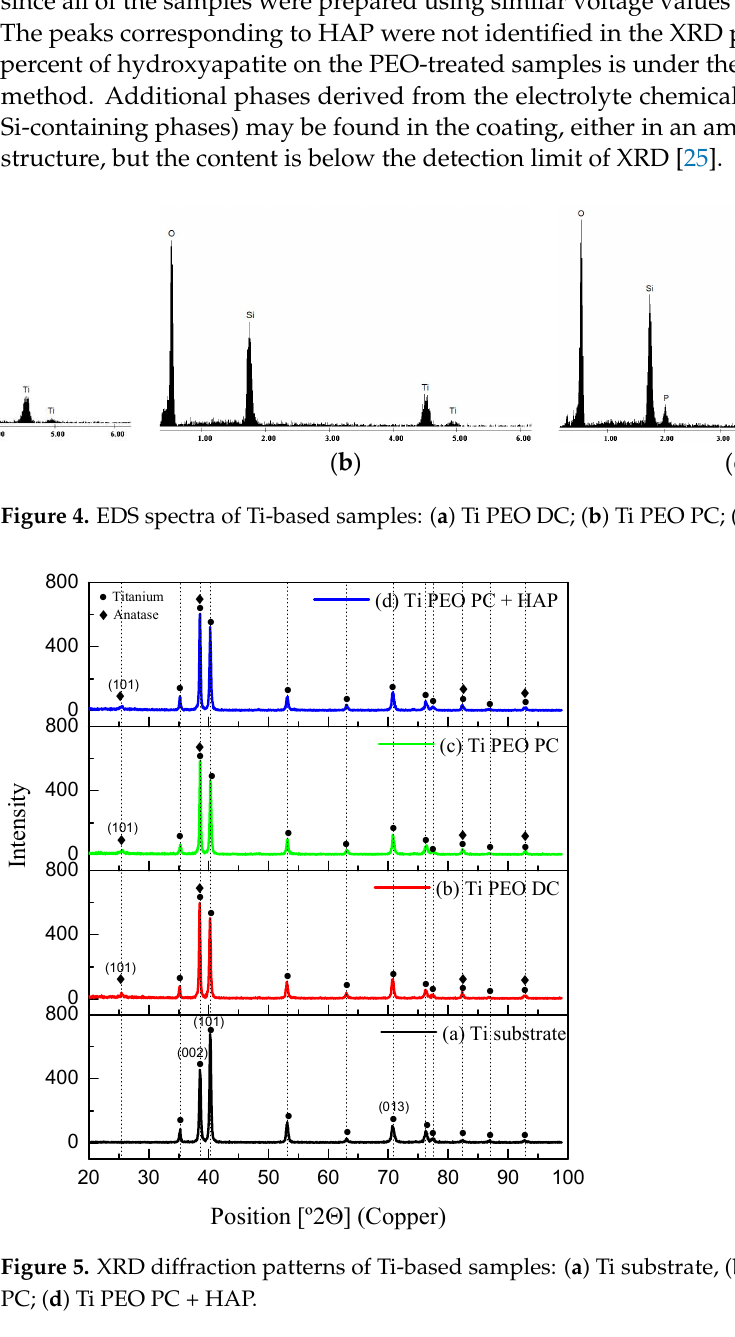
Figure 5. XRD diffraction patterns of Ti-based samples: ( a ) Ti substrate, ( b ) Ti PEO DC; ( c ) Ti PEO PC; ( d ) Ti PEO PC + HAP.